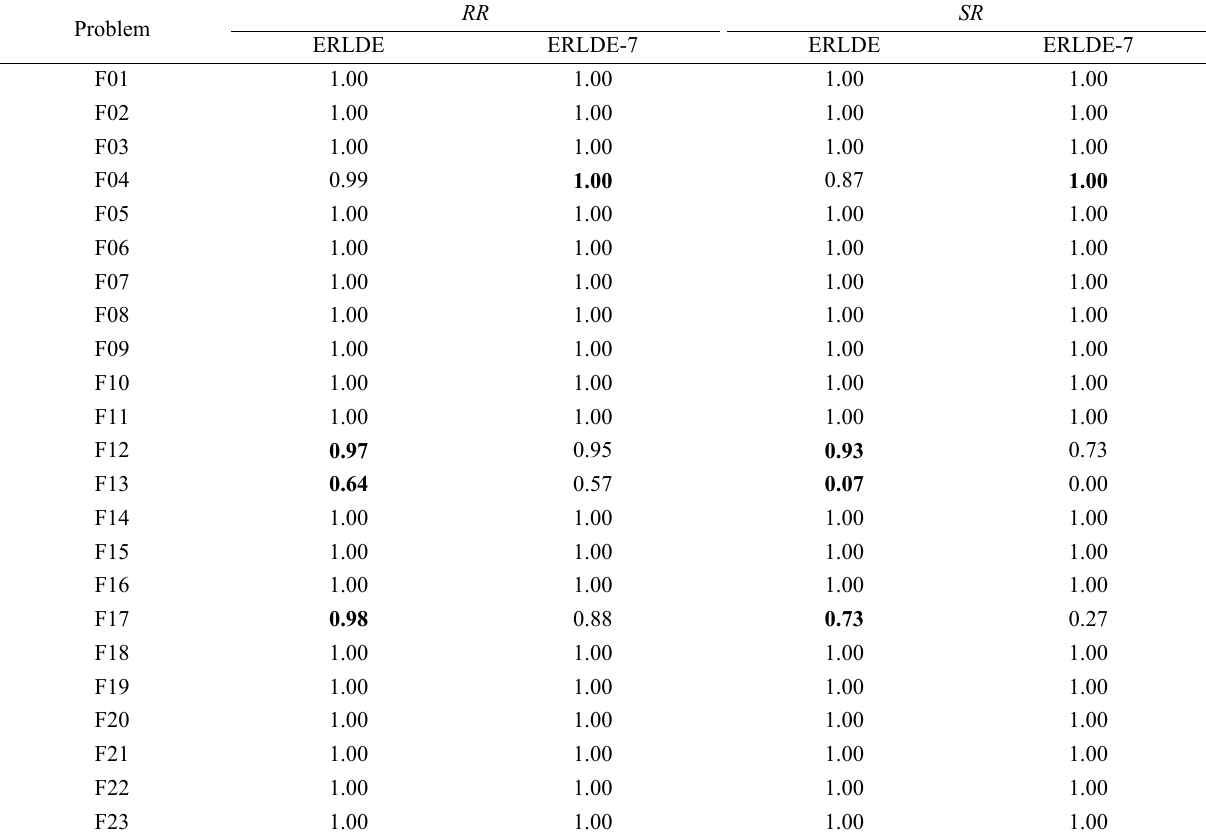
Table A6 Comparison between ERLDE and ERLDE-7 with respect to RR and SR